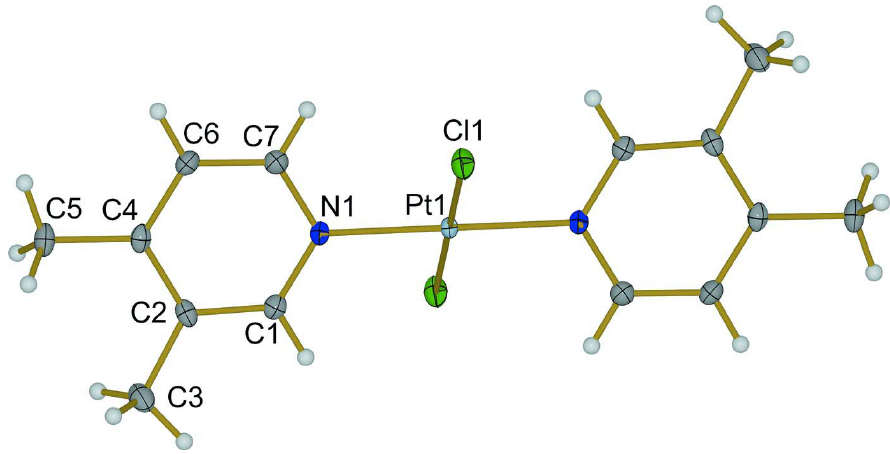
Figure 1 The molecular structure of the title molecule, with the atom-numbering scheme. Displacement ellipsoids are drawn at the 50% probability